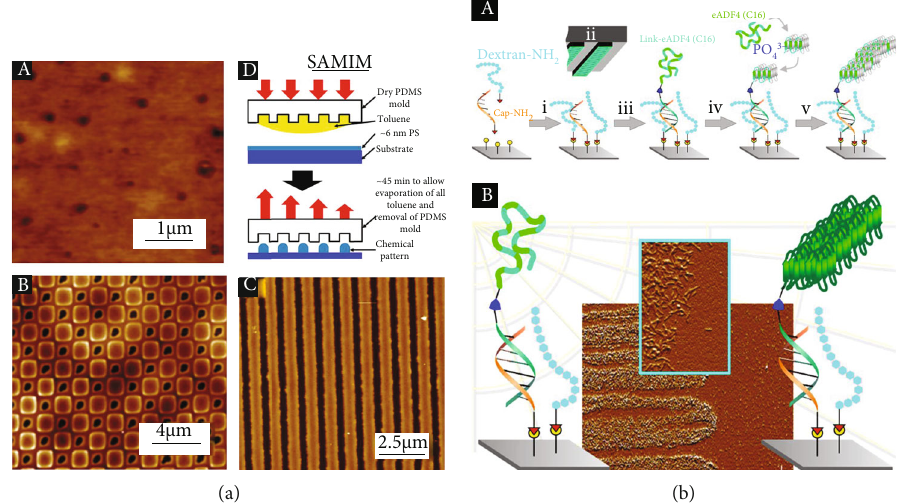
Figure 5: Using di ff erent techniques for patterning materials of recombinant spider silk proteins. (a) AFM images showing the morphology of C16 fi lms from HFIP: (A) surface morphology with a Z scales of 10 nm, (B) square pattern with a Z scale of 60 nm, (C) line pattern using the SAMIM technique with a Z scale of 60nm, and (D) representation of the SAMIM technique. Reproduced from S. L. Young et al., 2012, Copyright © 2012, American Chemical Society. (b) (A) Schematic representation of soft lithography-based patterning for localized fi bril self- assembly. The silicon surface was activated by the epoxy group, enabling the simultaneous introduction of the capture 5 ′ -amino oligonucleotides (cap-NH ) and passivation agents (i). A microcontact printing technique (ii) was used to pattern DNA-spider silk 2 conjugates (link-eADF4(C16)) (iii). The surfaces were treated with phosphate ions and monomeric spider silk protein eADF4(C16) to nucleate (iv) which led to the growth of surface bound β -sheet rich fi brils on the spotted conjugates. (B) Schematic diagram of surface microstructure formed by self-assembly of spidroin molecular chains. Reproduced from A. Molina et al., 2019, Copyright © 2018, American Chemical